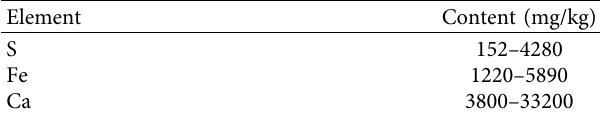
Table 1: Chemical composition of